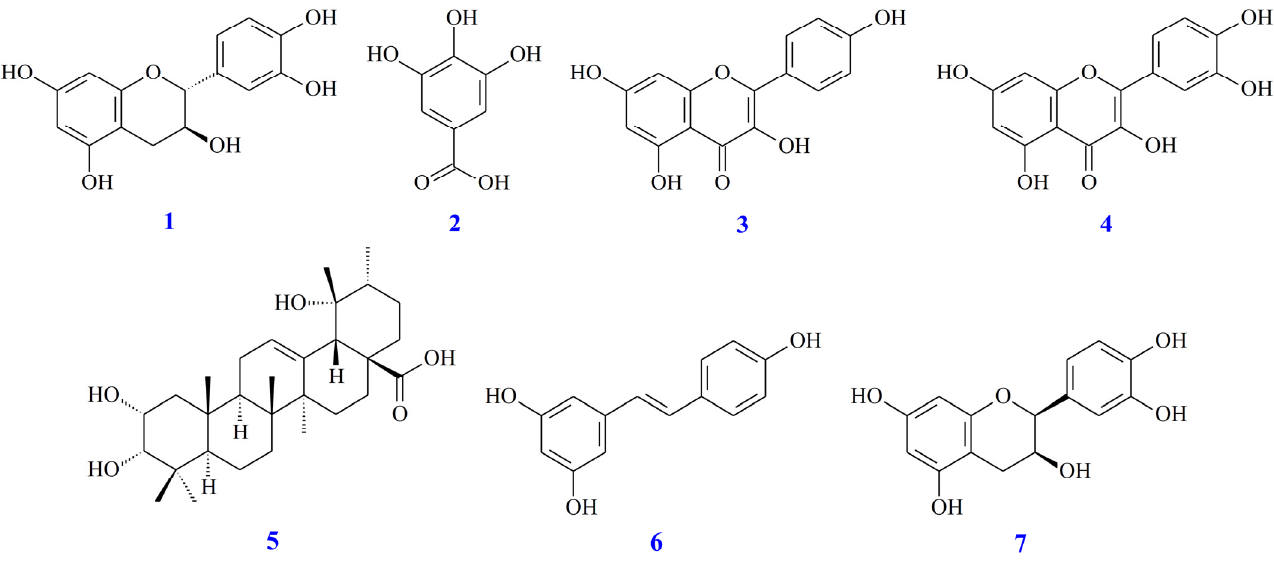
Figure 1. The chemical structures of catechin ( 1 ), gallic acid ( 2 ), kaempferol ( 3 ), quercetin ( 4 ), euscaphic acid ( 5 ), resveratrol ( 6 ), and epicatechin ( 7 ) from Ampelopsis japonica .